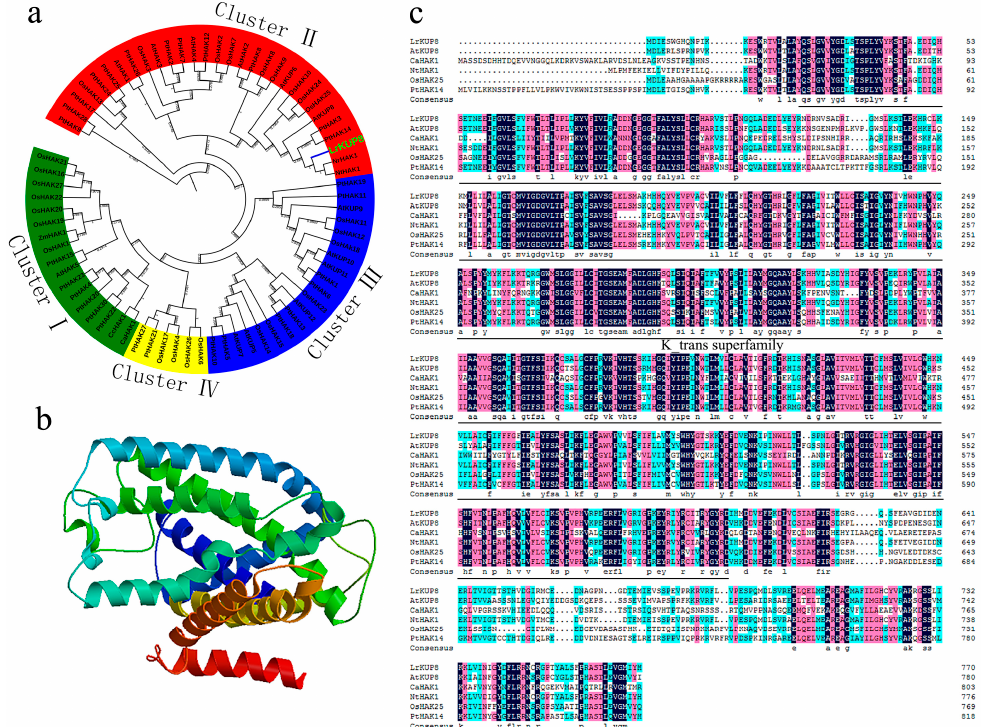
Figure 2. In silico analysis of the KT / KUP / HAK protein. ( a ) The phylogenetic tree using KUP transporters from A. thaliana , Nicotiana tabacum , O. sativa , and Populus . The tree topology was constructed using the Clustal W2 (http: // www.ebi.ac.uk / Tools / msa / clustalw2 / ) and MEGA programs. LrKUP8 is indicated by green enlarged font. ( b ) Protein prediction of LrKUP8. ( c ) Multiple alignments of amino-acid sequences of LrKUP8 and other plant KT / KUP / HAK